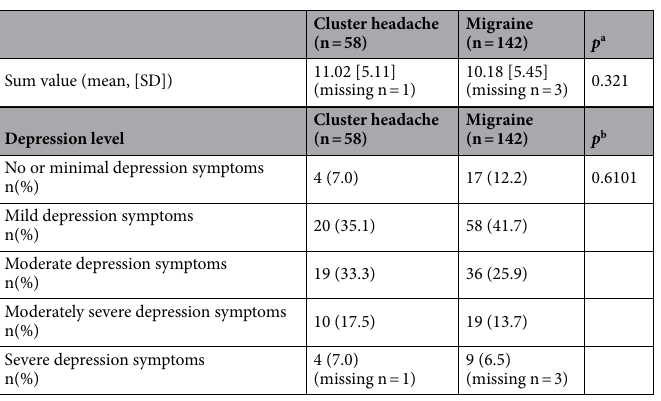
Table 9. PHQ-9 results for both headache types. a Welch test. b Pearson’s chi-squared